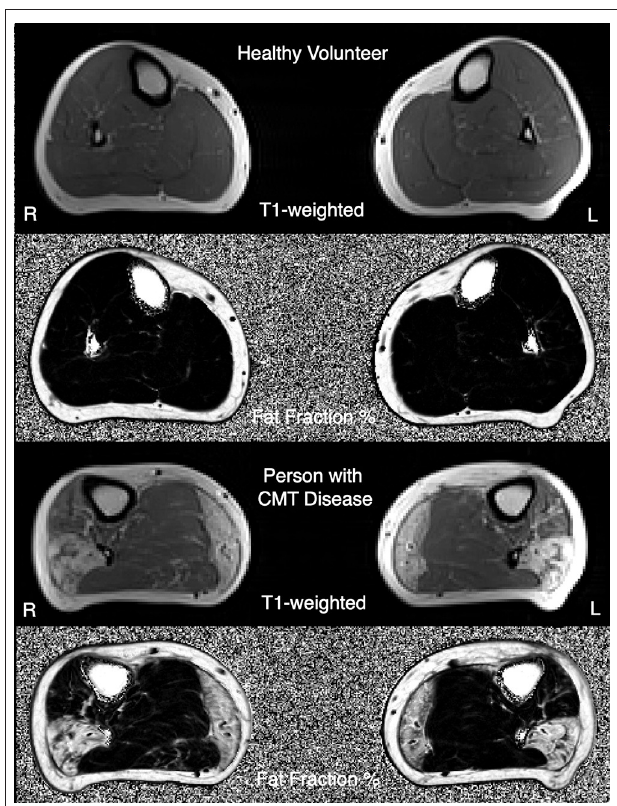
FIGURE 1 | Example T1-weighted MRI images, and three-point Dixon MRI-obtained quantitative fat-fraction maps, from a healthy volunteer (top images) , and a person with CMT1A (bottom images)